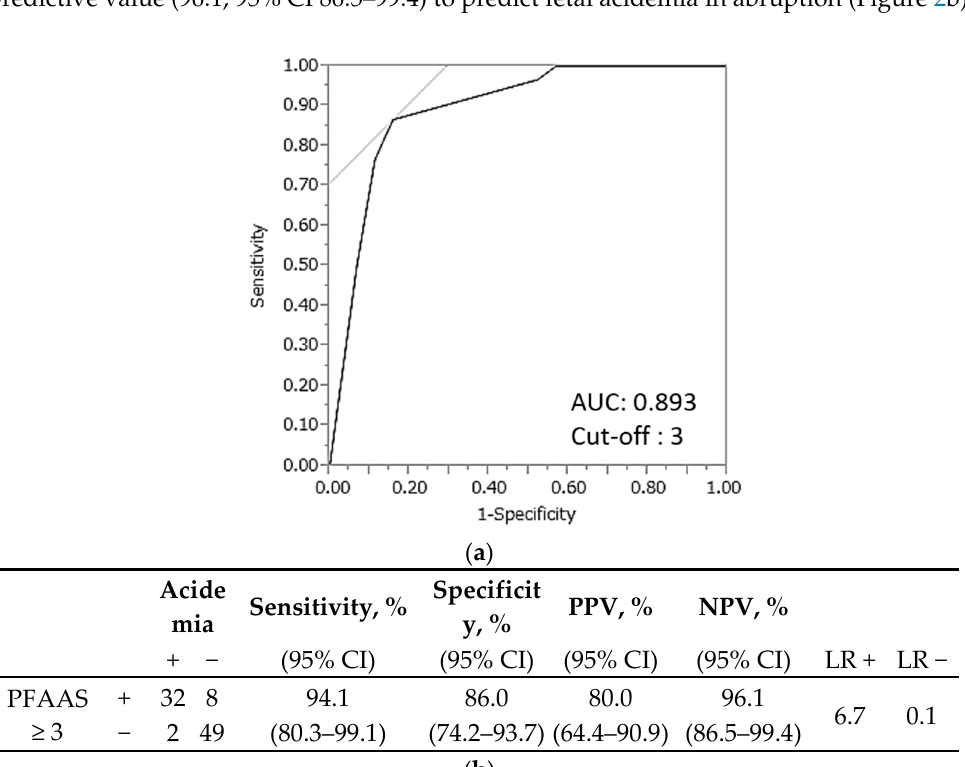
Figure 2. Prediction of fetal acidemia in placental abruption using the predictive fetal acidemia in abruption score (PFAAS) in the test set. ( a ) The area under the curve was 0.893, and the optimal cutoff value for the PFAAS was 3. ( b ) The sensitivity, specificity, positive predictive value, and negative predictive value were 94.1%, 86.0%, 80.0%, and 96.1%, respectively. CI, confidence interval; PPV, positive predictive value; NPV, negative predictive value; LR, likelihood ratio.